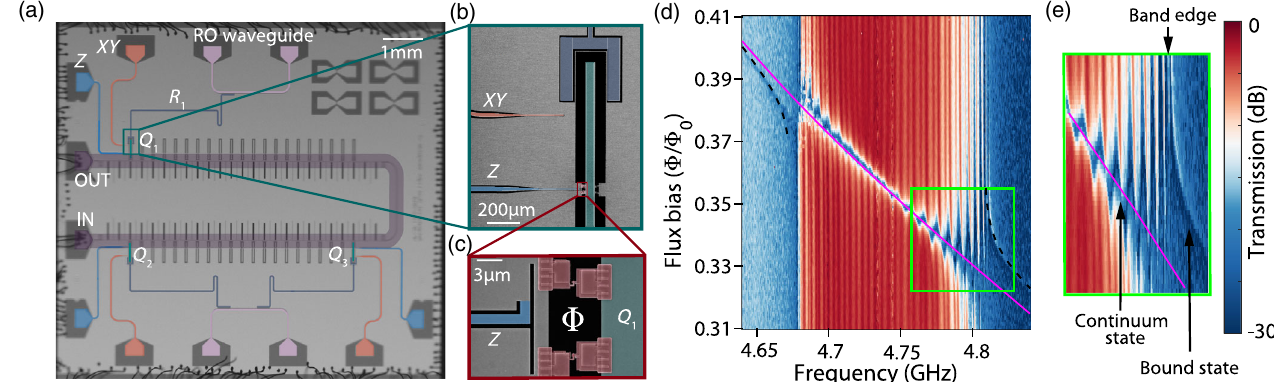
FIG. 2. Artificial atom coupled to a structured photonic reservoir. (a) False-colored optical image of a fabricated sample consisting of three transmon qubits ( Q 1 , Q 2 , and Q 3 ) coupled to a slow-light metamaterial waveguide composed of a coupled microwave resonator array. Each qubit is capacitively coupled to a readout resonator (false-color dark blue) and an XY control line (false-color red) and inductively coupled to a Z flux line for frequency tuning (false-color light blue). The readout resonators are probed through feedlines (false-color lilac). The metamaterial waveguide path is highlighted in false-color dark purple. (b) SEM image of the Q 1 qubit, showing the long, thin shunt capacitor (false-color green), XY control line, the Z flux line, and coupling capacitor to the readout resonator (false- color dark blue). (c) SEM enlarged image of the Z flux line and superconducting quantum interference device (SQUID) loop of the Q 1 qubit, with Josephson junctions and its pads false colored in crimson. (d) Transmission through the metamaterial waveguide as a function of the flux. The solid magenta line indicates the expected bare qubit frequency in the absence of coupling to the metamaterial waveguide, calculated based on the measured qubit minimum and maximum frequencies and the extracted anharmonicity. The dashed black lines are numerically calculated bound-state energies from a model Hamiltonian of the system; see Appendix E for further details. (e) Enlargement of transmission near the upper band edge, showing the hybridization of the qubit with the band edge, and its decomposition into a bound state in the upper band gap and a radiative state in the continuum of the